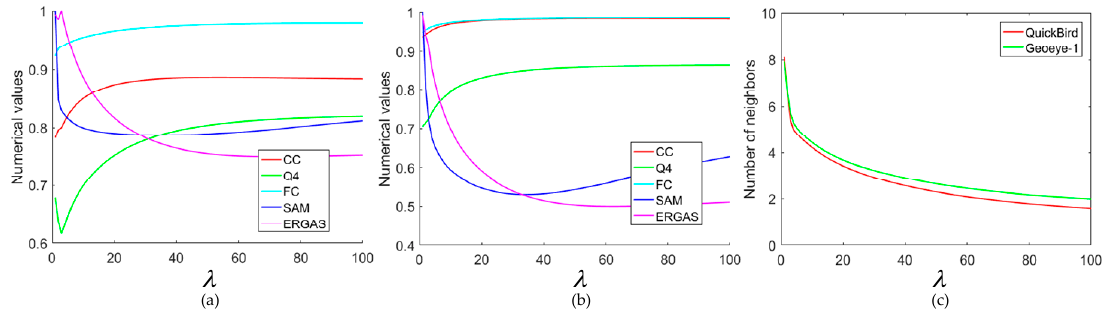
Figure 6. The variations of metrics and neighbors with different λ . ( a ) Performance influence of λ on QuickBird image datasets, ( b ) Performance influence of λ on Geoeye-1 image datasets, ( c ) Variations of neighbors with different λ on QuickBird and Geoeye-1 image datasets.